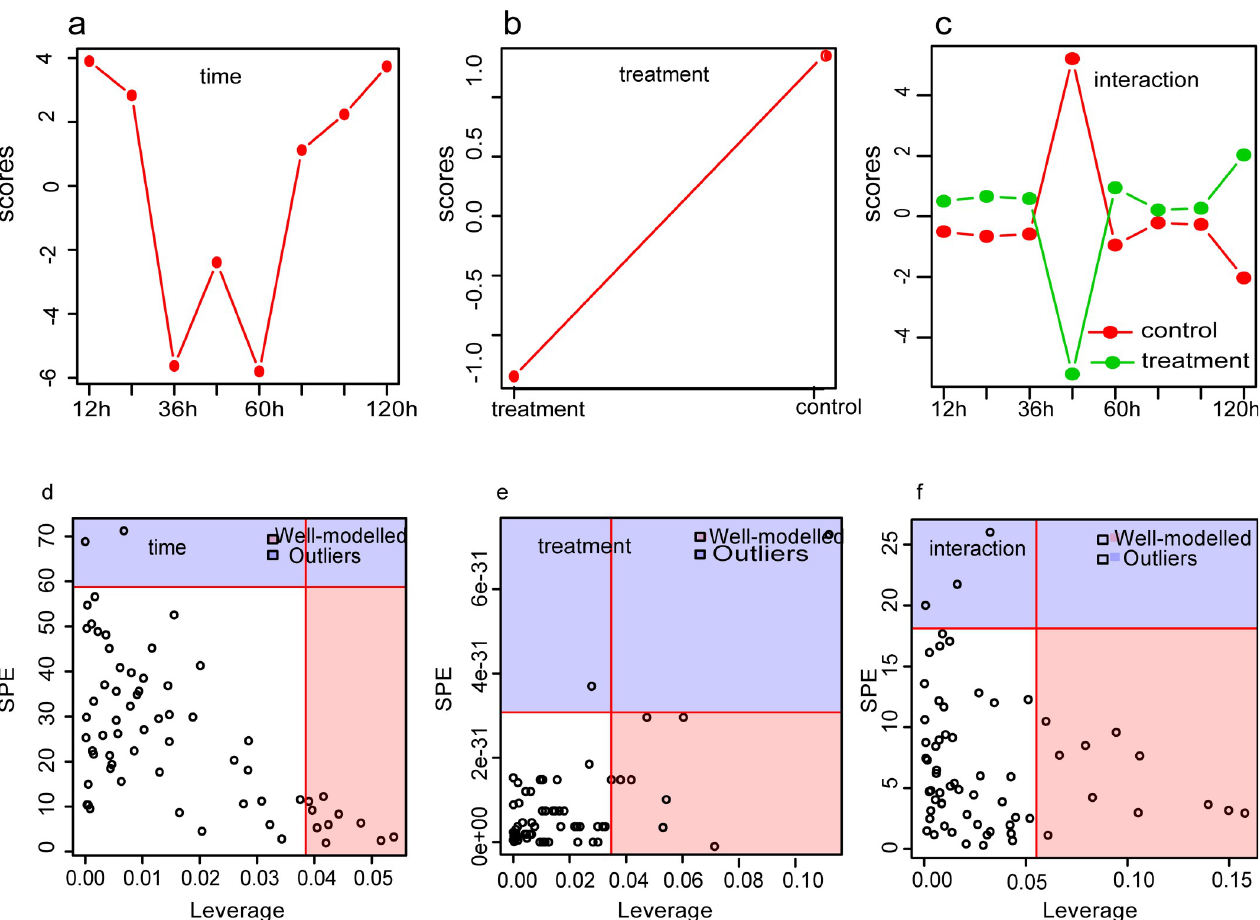
Fig 5. ANOVA-simultaneous component analysis (ASCA) of U . prolifera during fragmentation-induced proliferation. (a-c) Major pattern associated with time, treatment and their interaction; (d-f) ASCA selection of important variables (metabolites) associated with time, treatment and their interaction by leverage/SPE analysis. The list of well-modeled metabolites refer to Table